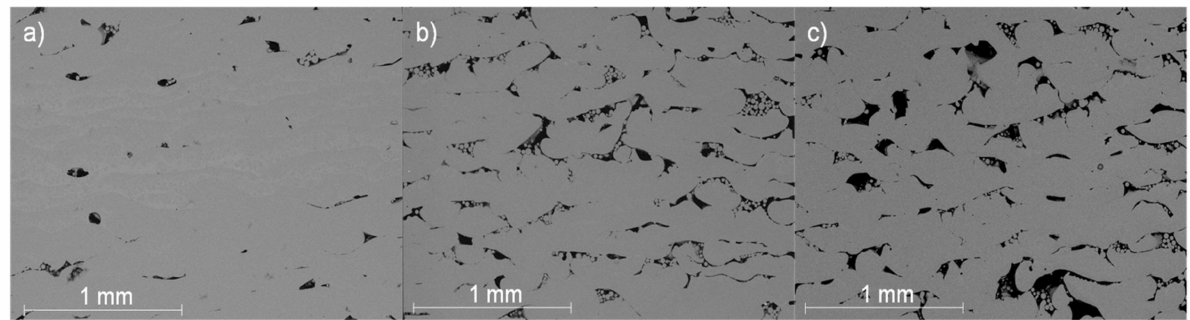
Figure 3. Optical images of the samples: ( a ) Ti-20 × 1; ( b ) Ti-33 × 1; ( c ) Ti-50 ×